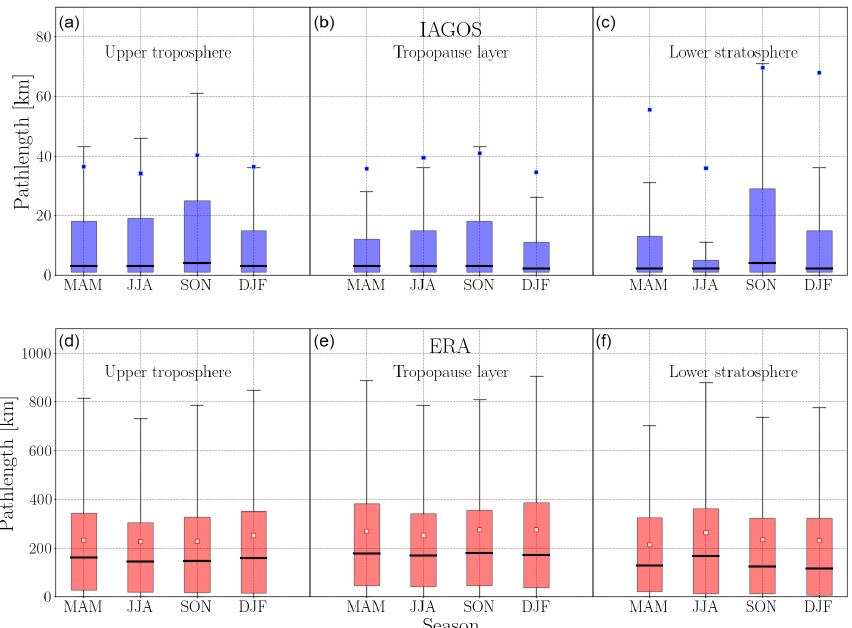
Figure 11. Box-and-whisker plot of the seasonal cycle of pathlengths of ISSR for different atmospheric layers in IAGOS (a–c) and ERA (d–f) . For each box, the squares denote the mean pathlength and black lines the median pathlength,